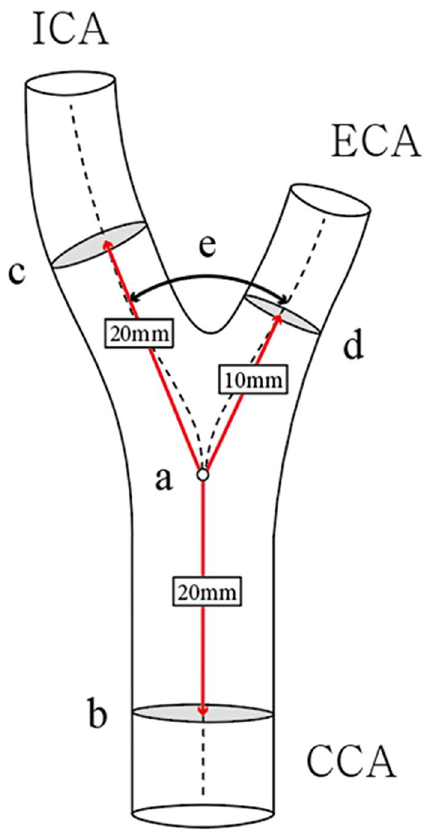
Figure 1. Geometric parameters of the carotid